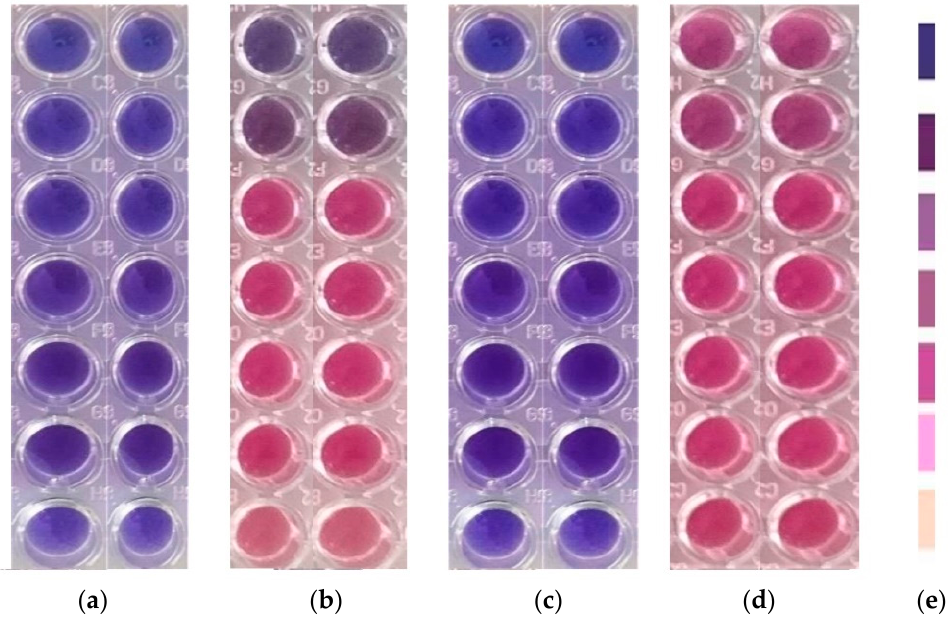
very good; violet—good; purple pink—moderate; light pink—low; pink—very low; white—no ef- fect. CTR—Ceftriaxone and F-UBE-HPC—Bioadhesive film loaded with U. barbata dry ethanol ex- tract; a,c,e,g well plates examined with a free eye; b,d,f,h well plates analyzed at 470 nm.